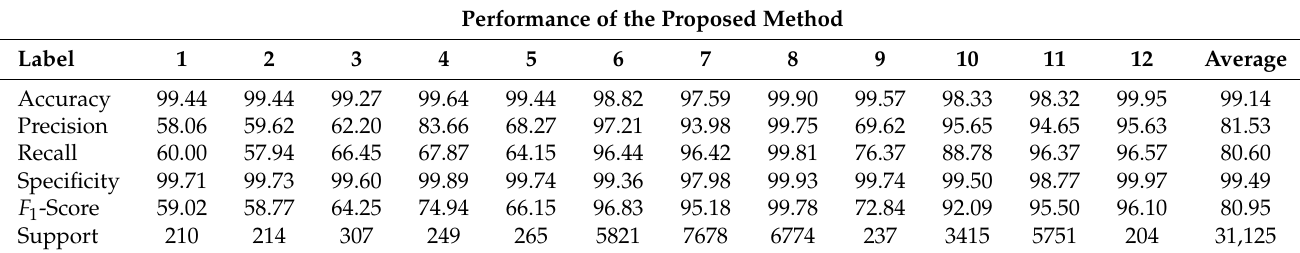
Table 4. Performance (%) obtained by the BERT model of the activity recognition method using UP-Fall.